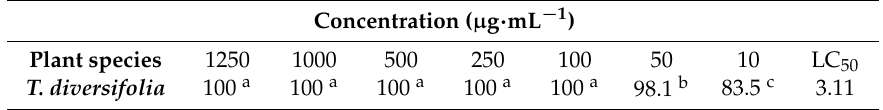
Values with equal superscript letters represent significant equality in the concentrations of essential oils.